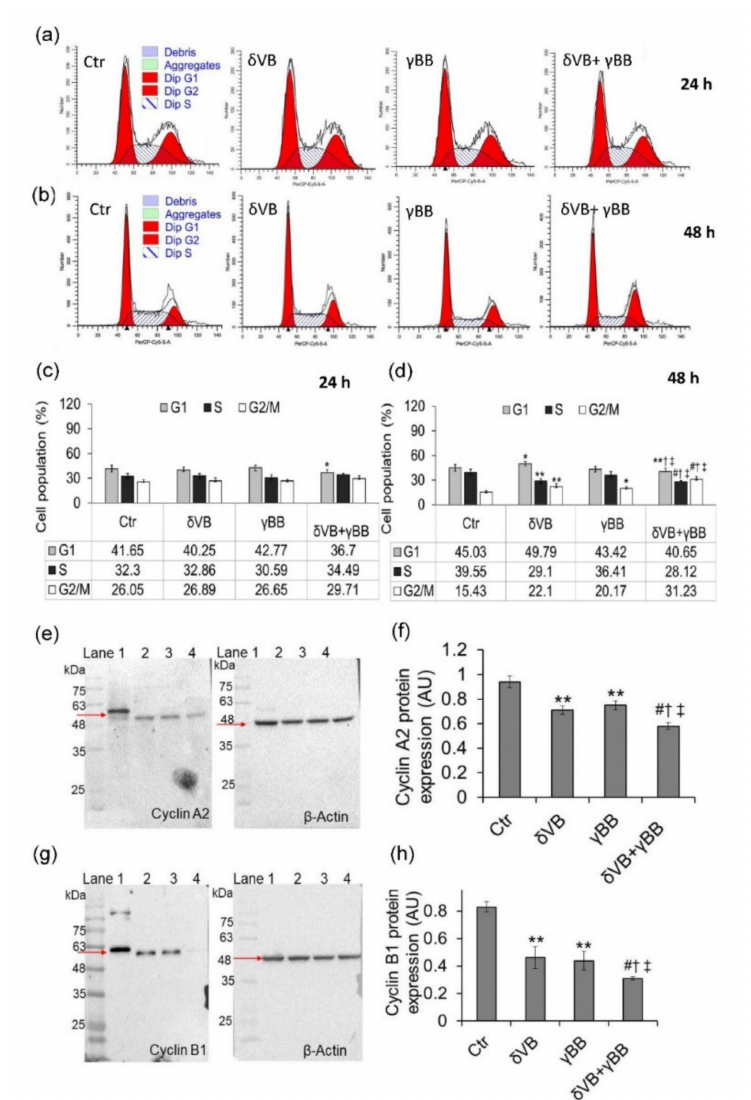
Figure 3. Cell cycle analysis. ( a – d ). Representative cell cycle analysis and average of Cal 27